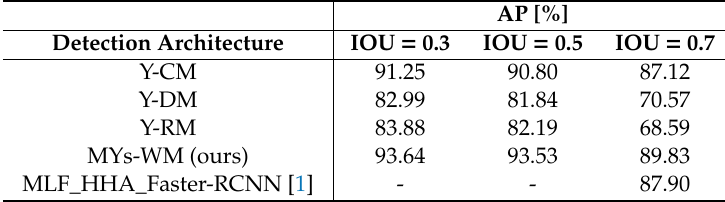
Table 1. Comparison of detection of cars according to intersection of union (IOU).